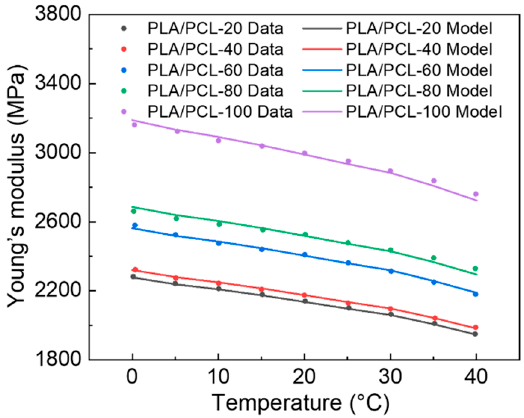
Figure 5. Prediction results of effective moduli versus temperatures for printed PLA/PCL samples with different infill densities. Table 3. Parameters in two-step model for PLA/PCL printed samples.